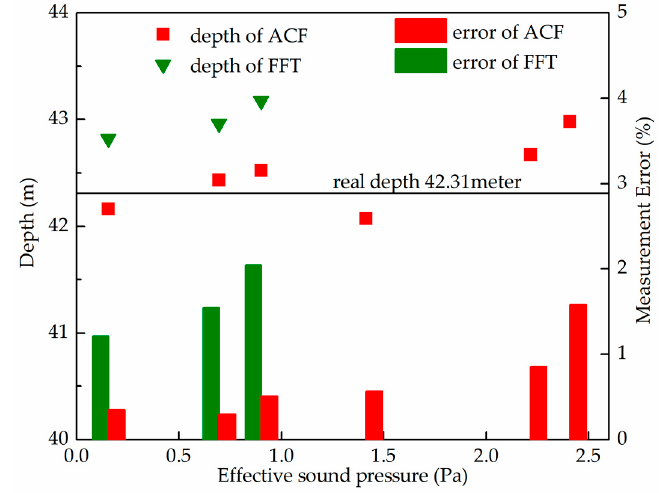
Figure 16. Comparison of liquid level determination between FFT and ACF under different noise levels.